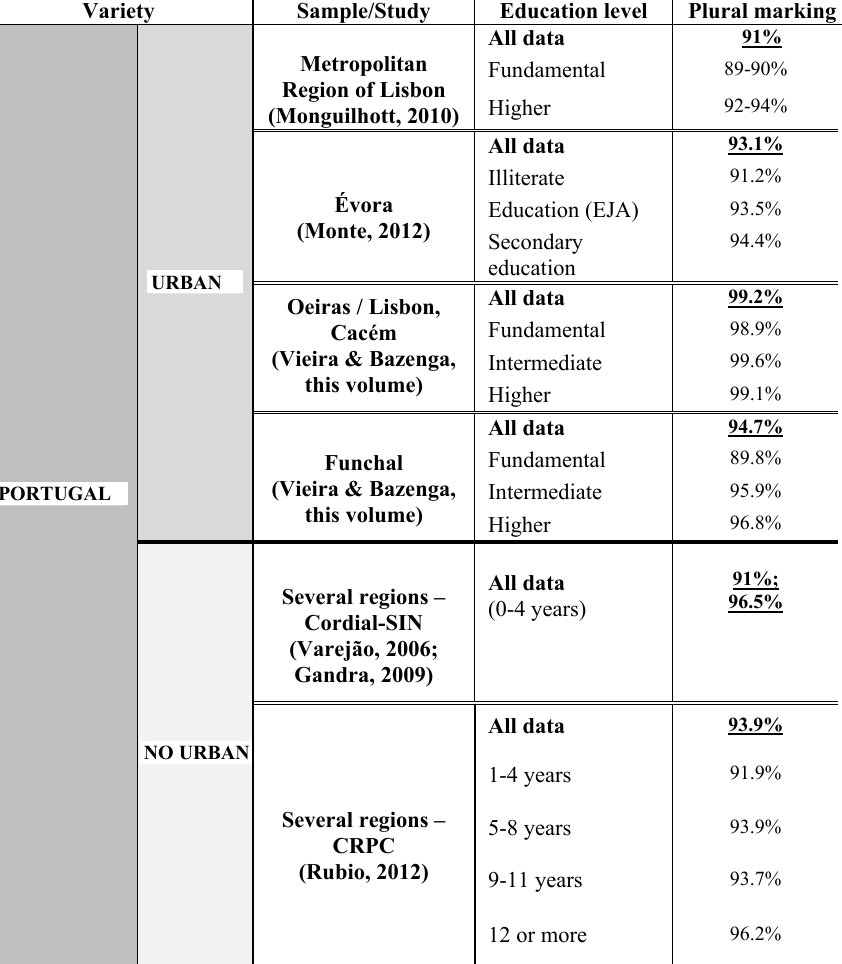
Table XXIII: Frequency of plural marks in different studies on third person plural verbal agreement in EP